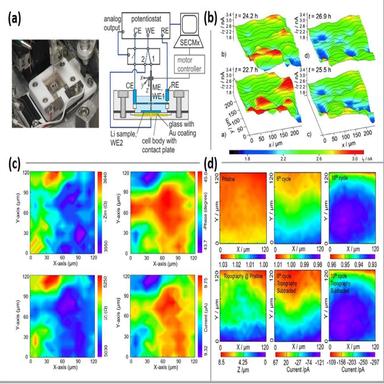
(a) The designed lithium symmetric cell for in-situ SECM probing, photograph (left) and schematic (right) (Reproduced with permission from ref. Copyright 2020 Wiley–VCH); (b) feedback patterns of the SEI layer covering on the graphite anode in LiClO4/PC electrolyte (Reproduced with permission from ref. Copyright 2014 Wiley–VCH); (c) 2D electrochemical-property mapping of TiO2 electrodes in LiTFSI-based aqueous electrolyte, reactance (top-left), impedance magnitude (bottom-left),